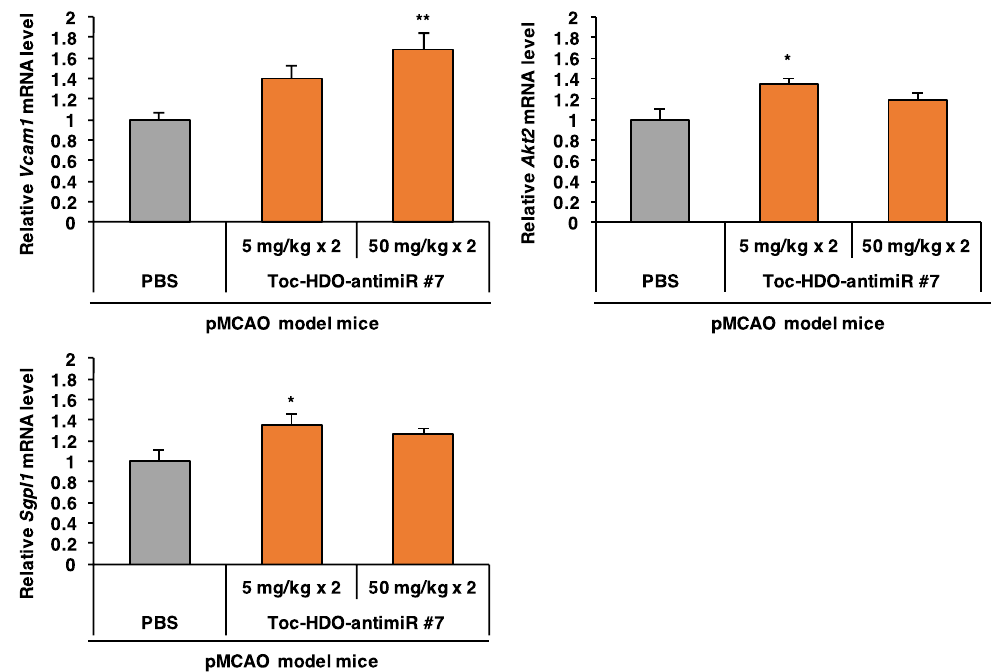
Figure 5. Upregulation of miR-126 target genes by Toc-HDO-antimiR #7 in ischemic stroke. qRT-PCR analysis of the mRNA levels of the miR-126 downstream genes, Vcam1, Akt2 , and Sgpl1 in the ischemic region of pMCAO model mice after two intravenous injections (at 1-week intervals) of Toc-HDO-antimiR #7 at 5 mg/ kg or 50 mg/kg. Data are relative to Gapdh mRNA levels and are presented as the mean ± s.e.m. (n = 3 per group. * P < 0.05, ** P < 0.01 versus PBS control). P values were calculated using one-way ANOVA followed by Dunnett’s